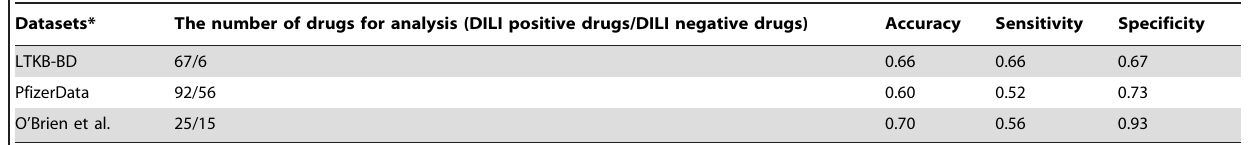
Table 2. Performance of DILI prediction system (DILIps) on three literature datasets.